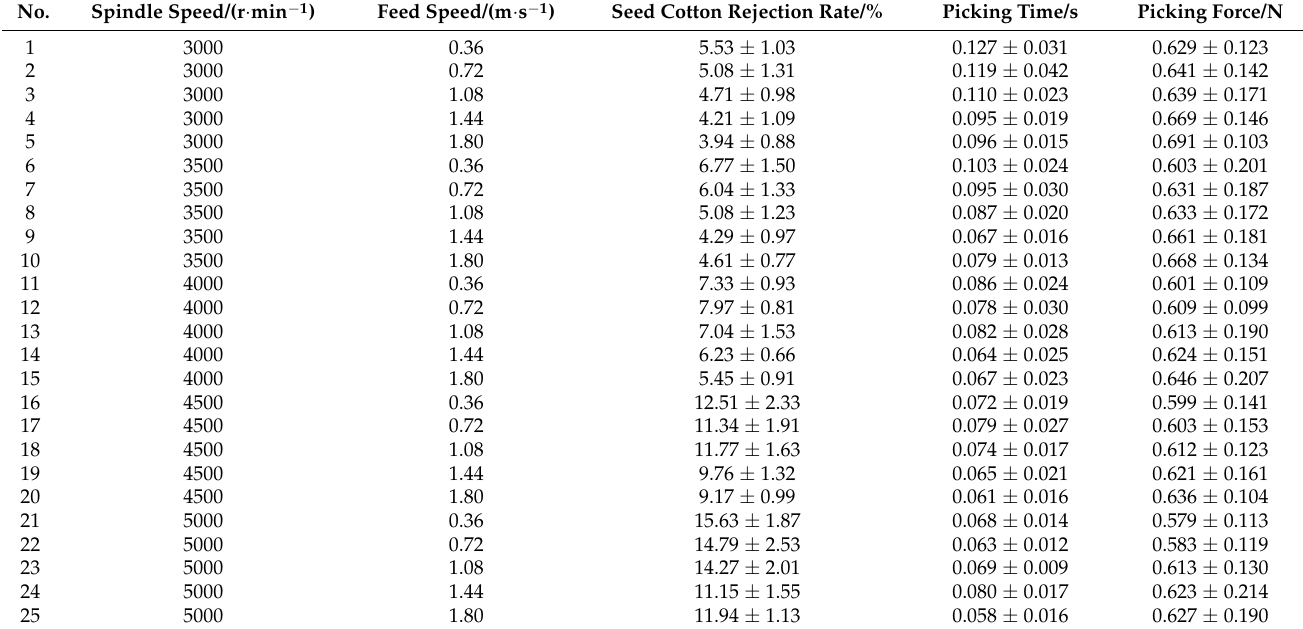
Table 2. Full factor test program and results.